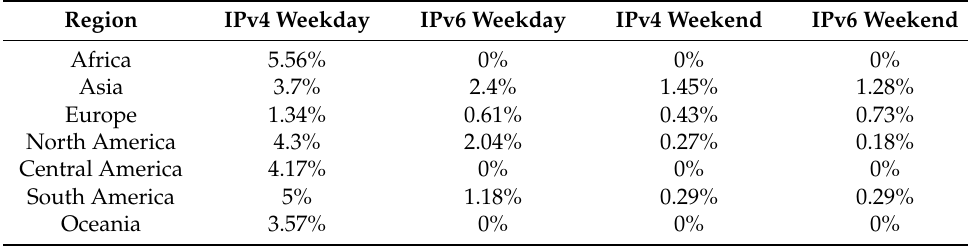
Table 3. Breakdown of packet loss by region.